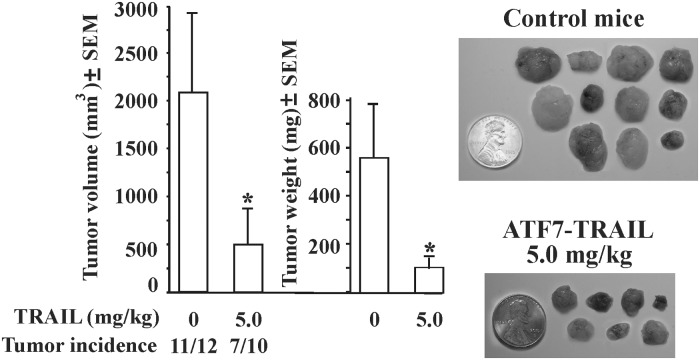
ATF7-TRAIL exhibits a high anti-tumor activity in mice.Left panel, tumor volume and weight of the vehicle-treated and experimental mice that received PBS and 5 mg/kg/day ATF7-TRAIL, respectively. Tumor incidence per group is shown below the bars. *P = 0.004. Right panel, tumors of the control and experimental mice.